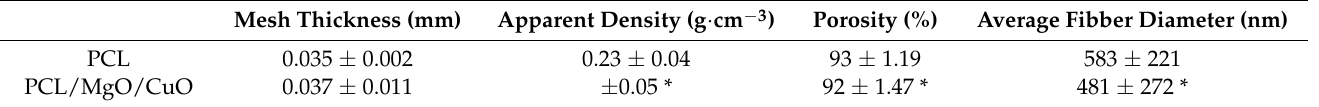
Table 2. Apparent density and porosity of the PCL electrospun meshes, and PCL electrospun meshes dopped with MgO and CuO NPs